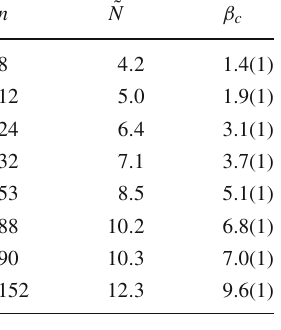
Table 3 β c -values for the weighted and not-weighted linear discretisation L m for 1 ≤ m ≤ 5 determined for d = 4 on 10 4 lattices. Orders ˜ N are approximations according to Eq. (33), rounded to one digit